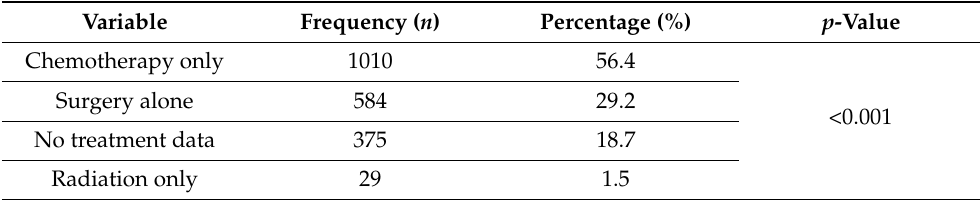
Table 4. Treatment of 1998 Patients with Primary Peritoneal Mesothelioma from the Surveillance, Epidemiology, and End Results (SEER) database,